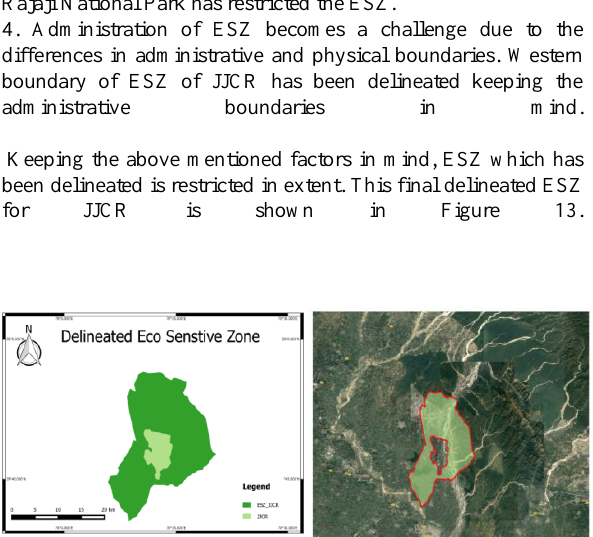
Figure 13 – Final ESZ for JJCR. The google earth image shows the final delineated ESZ.